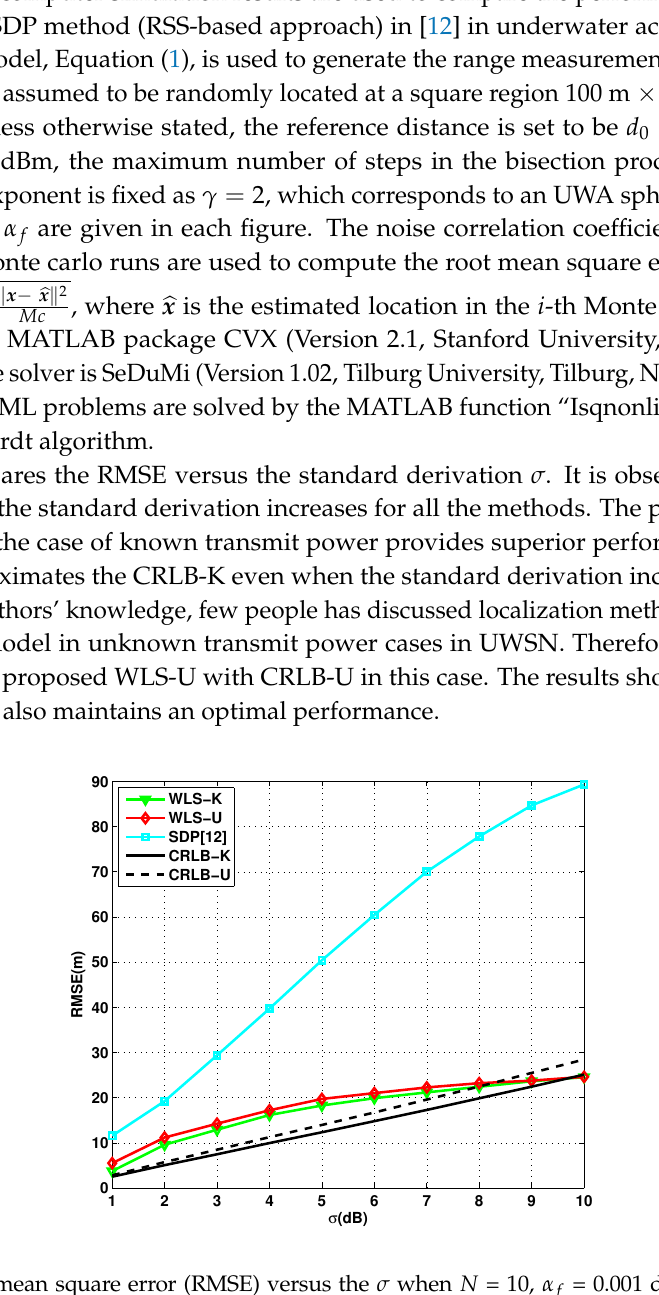
Figure 4. Root mean square error (RMSE) versus the σ when N = 10, α f = 0.001 dB/m ( f = 9 kHz), and ρ =